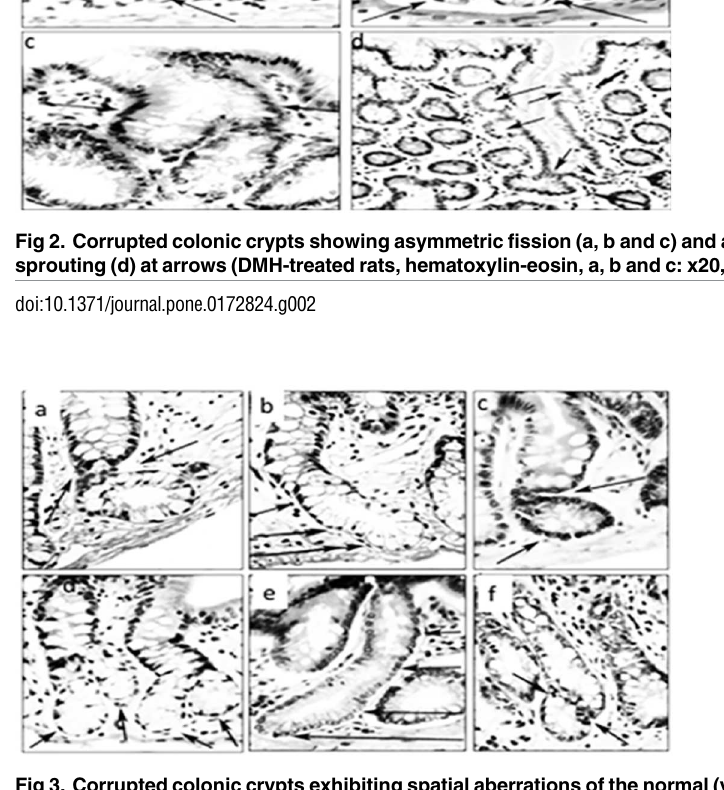
Fig 3. Corrupted colonic crypts exhibiting spatial aberrations of the normal (vertical) axis at arrows. Note L-shapedcrypts ( a and c ), crypts with lateral sprouting ( d and f ), and with obliqueaxis ( b and e ) (DMH- treated rats, hematoxylin-eosin, a to f : x20).